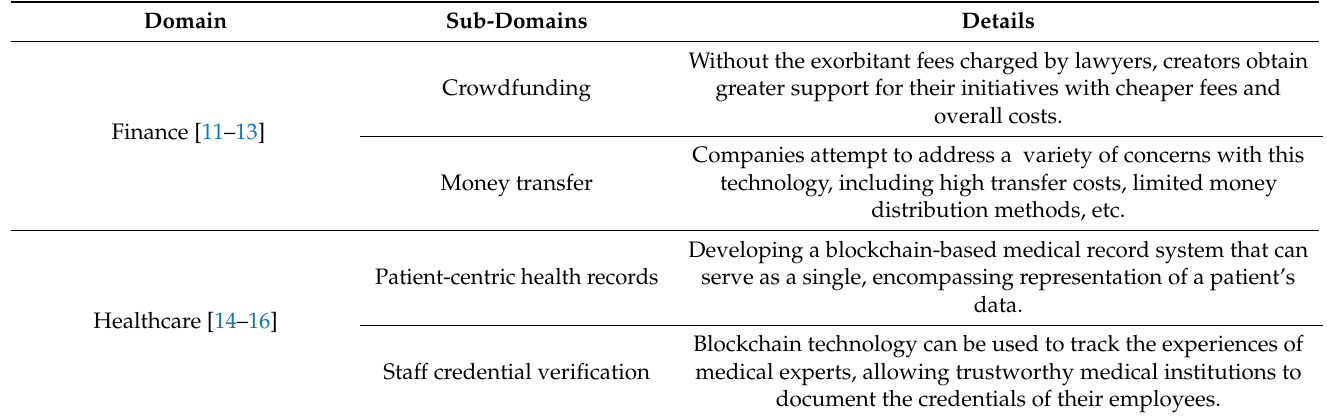
Figure 1. Blockchain application domains covered by this survey. Table 1. Some examples of the use of blockchain technology in different